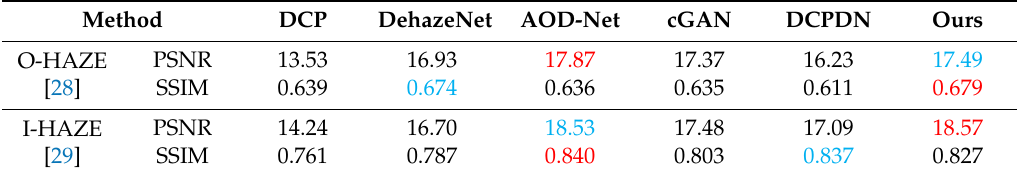
Figure 6. Comparison of state-of-the-art dehazing methods using synthesis images. Table 2. Average PSNR and SSIM results of O-HAZE and I-HAZE. (red font indicates the highest value, followed by blue font).